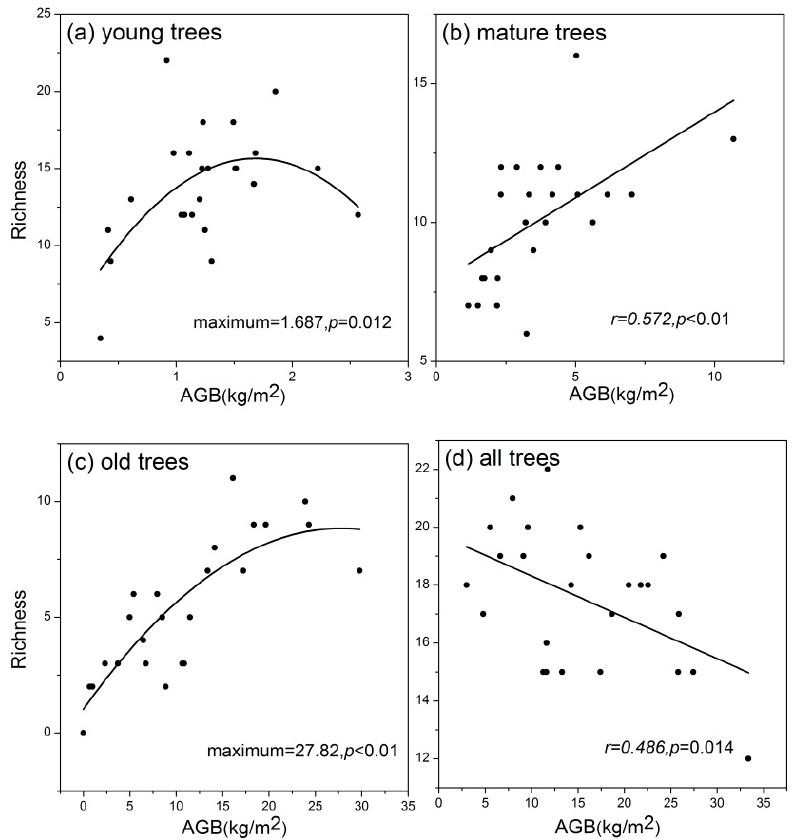
Figure 3. Relationship between tree species richness and above ground biomass (kg/m 2 ) for all trees and different growth stages: ( a ) young trees; ( b ) mature trees; ( c ) old trees; ( d ) all trees. The regression line is plotted if the relationship is significant ( p < 0.05), with the unimodal relationship examined by the Mitchell ‐ Olds and Shaw (MOS) test.